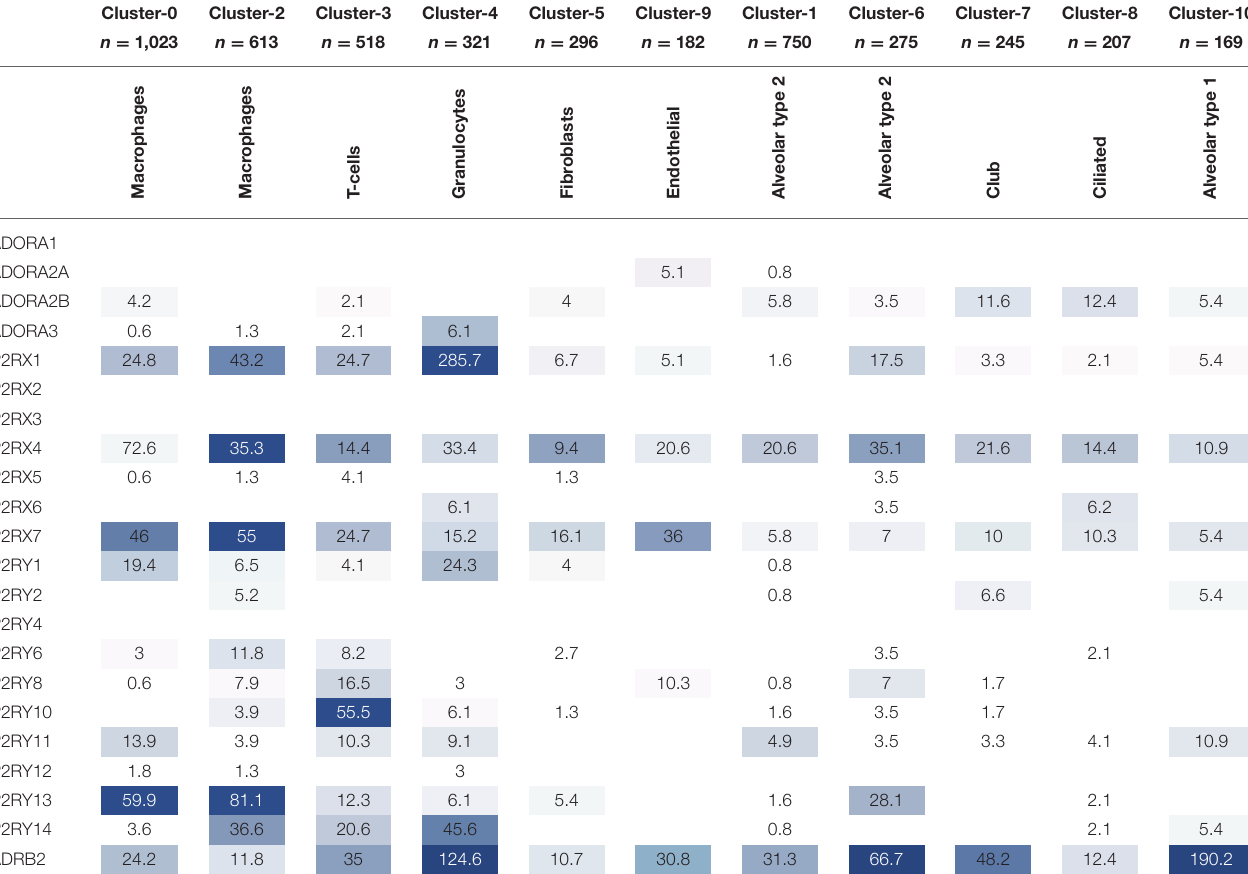
As a reference, expression data are also provided for the beta-2 adrenergic receptor (ADRB2), a GPCR that is currently a target for the treatment of respiratory disease. RNA expression data for each gene in all 11 cell clusters within lung tissue were obtained from the Human Protein Atlas (HPA) Cell Type Atlas [https://www.proteinatlas.org (v20.0) (24, 25), date first accessed: 15/01/2021]. Data are transcripts per million protein coding genes (pTPM), and cell numbers for each individual cell cluster are given at the top of each corresponding column. Data are grouped into broad cell types, with blood and immune cell types grouped in the first four columns, and epithelial cell types grouped in the last five columns. All data are color-coded according to expression level, with darker color indicating higher